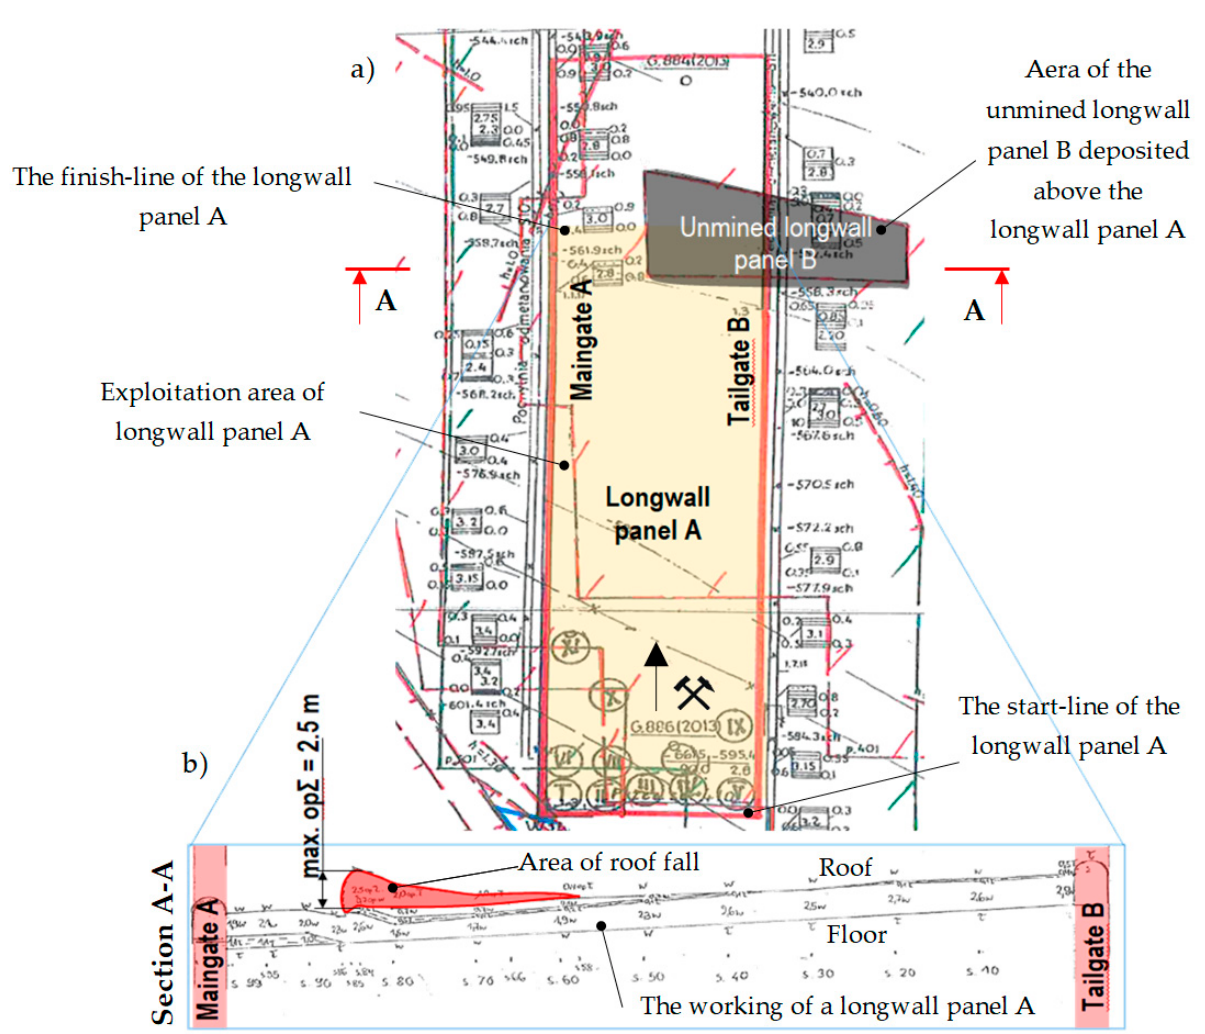
Figure 2. Map of the exploited coal seam A ( a ) and measurement sketch ( b ) of the height of exposure in the roof of the longwall working, where: s.—section number, w—thickness of coal seam, op Σ —the height of exposure of the roof in the longwall workings.